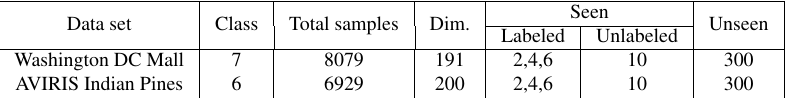
Table 1: Experimental settings.